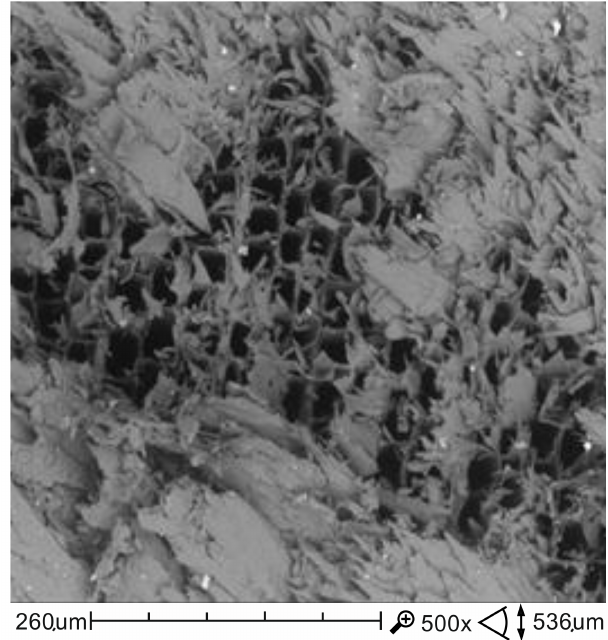
Figure 6. SEM images of the non-impregnated porous wood structure at a magnification of 500 ×